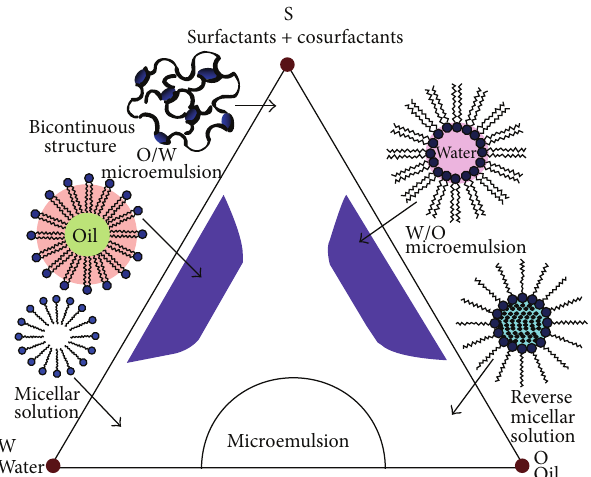
Figure 13: Theoretical ternary phase diagram of microemulsion systems